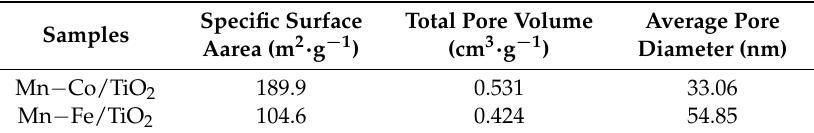
Table 1. Physical properties of Mn − Co/TiO 2 and Mn − Fe/TiO 2 nanocatalysts.